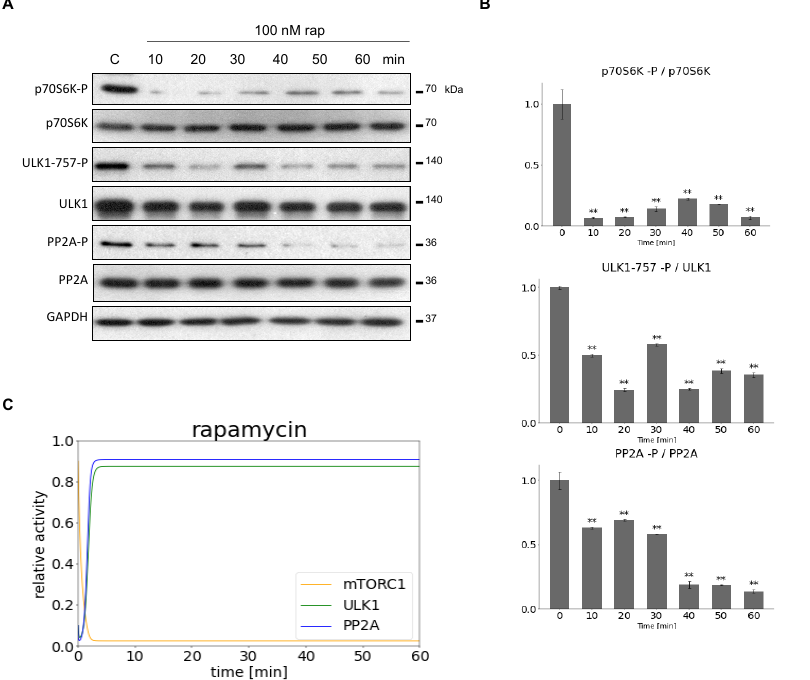
Figure 2. Inhibiting mTORC1 activity to set the parameters of our minimal model. HEK293T cells were denoted in time after 100 nM rapamycin treatment. ( A ) The markers of ULK1 (ULK1-757-P), PP2A (PP2A-P) and mTORC1 (p70S6K-P) were followed by immunoblotting. GAPDH was used as loading control. ( B ) Densitometry data represent the intensity of ULK1-757-P normalized for total level of ULK1, PP2A-P normalized for total level of PP2A and p70S6K-P normalized for total level of p70S6K. For each of the experiments, three independent measurements were carried out. Error bars represent standard deviation asterisks indicate statistically significant difference from the control: ns—nonsignificant; **— p < 0.01. ( C ) The computational simulation is determined upon rapamycin treatment (mTORT = 0.1). The relative activity of mTORC1, PP2A, ULK1 is